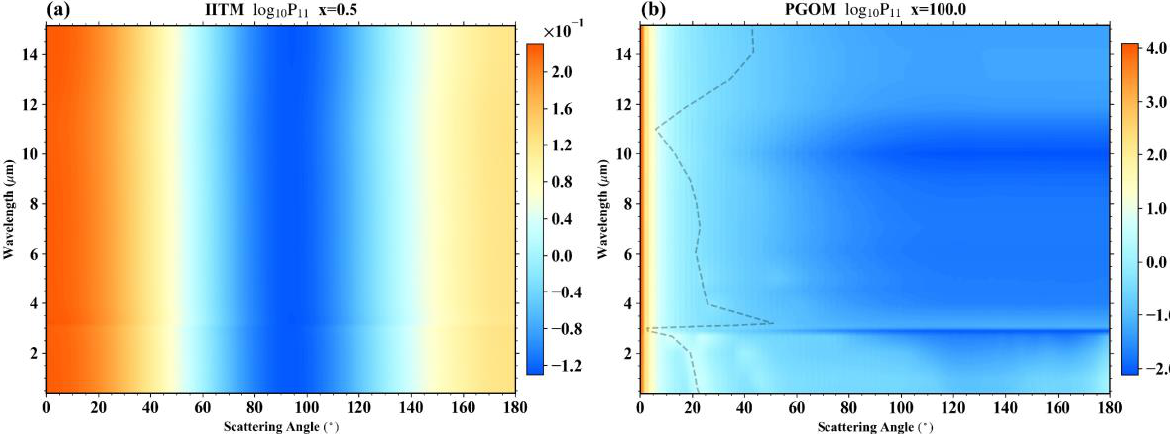
Figure 7. Scattering phase function trends of a regular hexagonal prism of unit aspect ratio for wavelengths of 0.4–15 µ m. Size parameters are x = 0.5 ( a ) and x = 100 ( b ). The refractive index of ice corresponds to the incident wavelength, as shown in Figure 1.